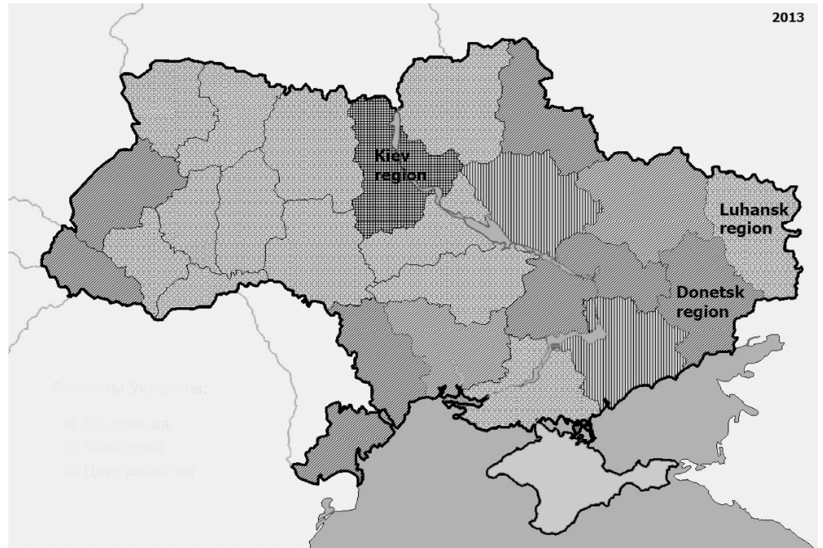
Figure 7. Mapping sustainable development of regions in Ukraine according to their affiliation to the attributive groups in 2013